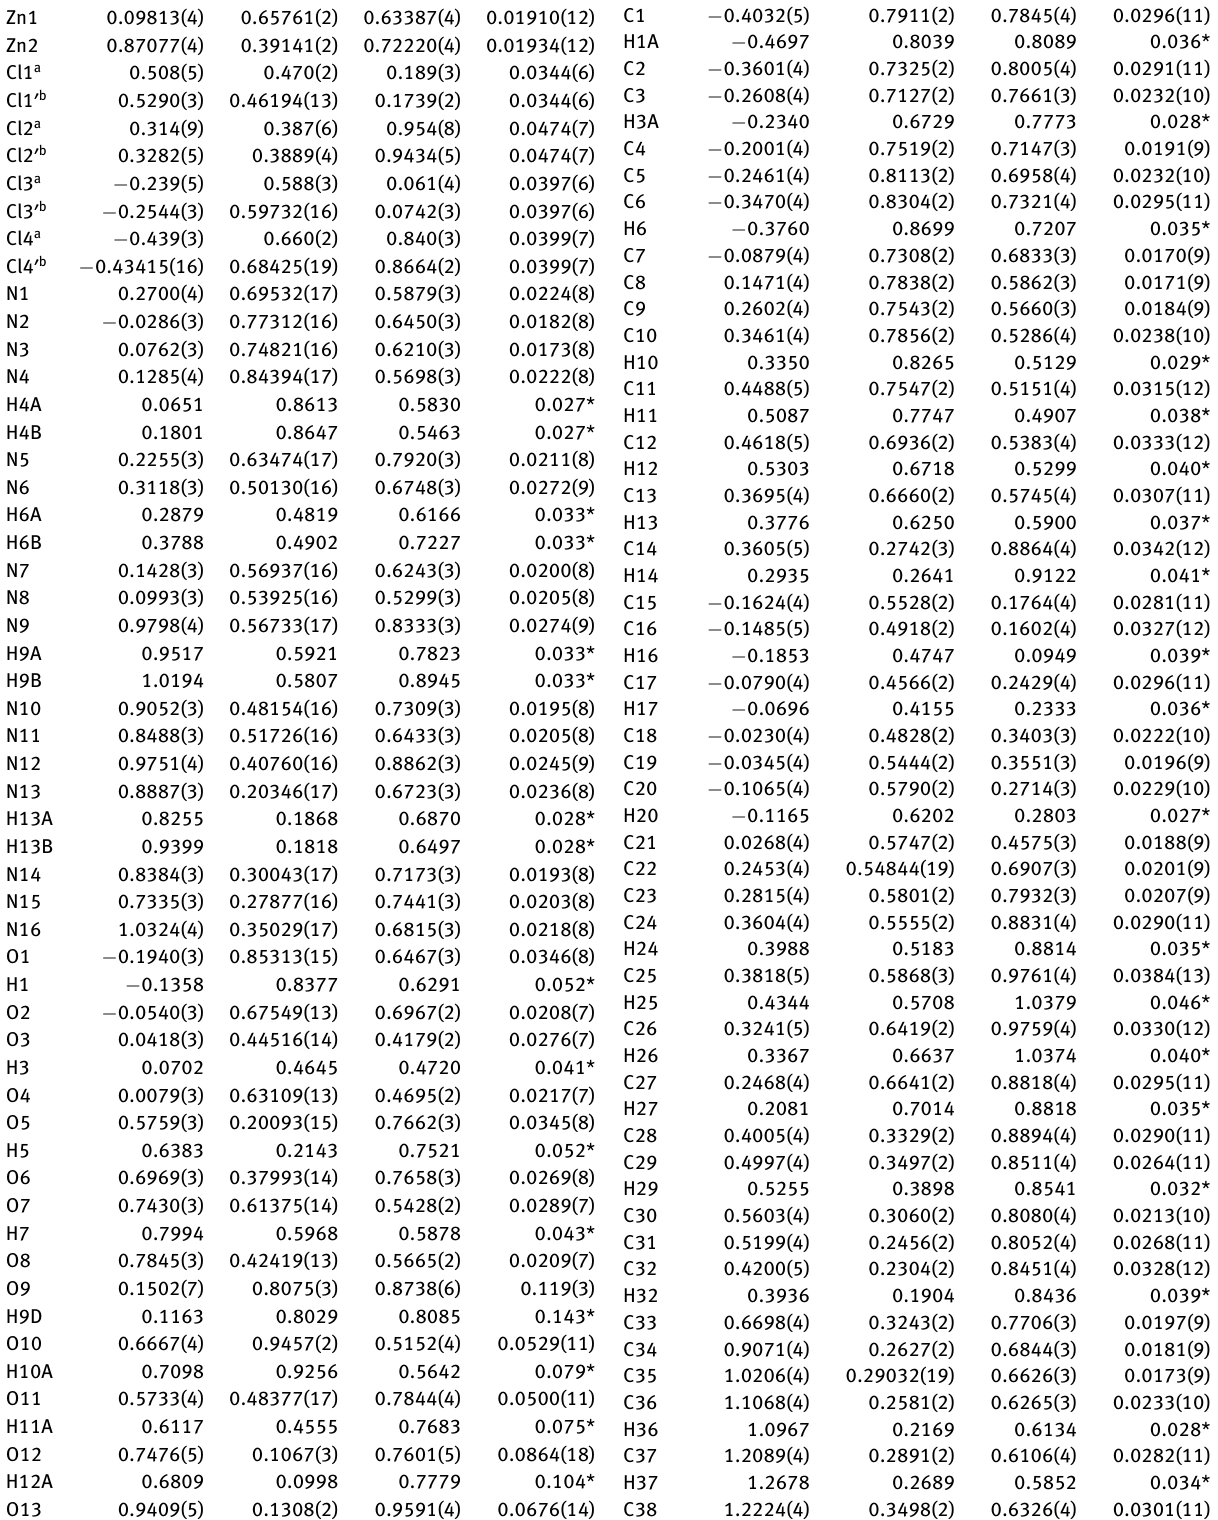
Table 2: Fractional atomic coordinates and isotropic or equivalent isotropic displacement parameters (Å 2